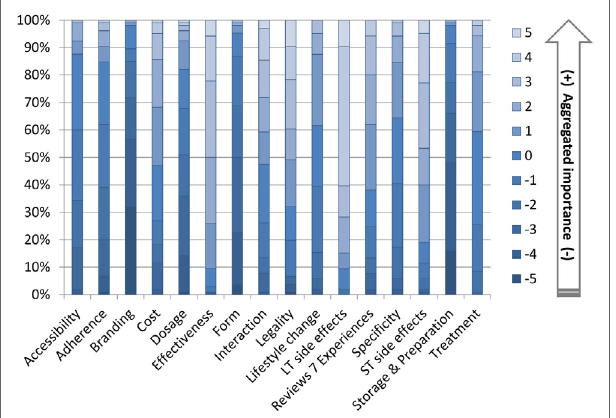
FigUre 4 | An illustrative example of personal preferences for attributes. Person A: a 21-year-old male who is happy with his current weight and he does not want to lose weight, at risk for disordered eating score is 1/6; Person B is an 18-year-old male who is happy with his current weight and he does not want to lose weight, at risk for disordered eating score is 0/6; Person C is a 20-year-old female, who is not happy with the current weight and she wants to lose weight, at risk for disordered eating score is 4/6. Black line represents the average BWS score for the